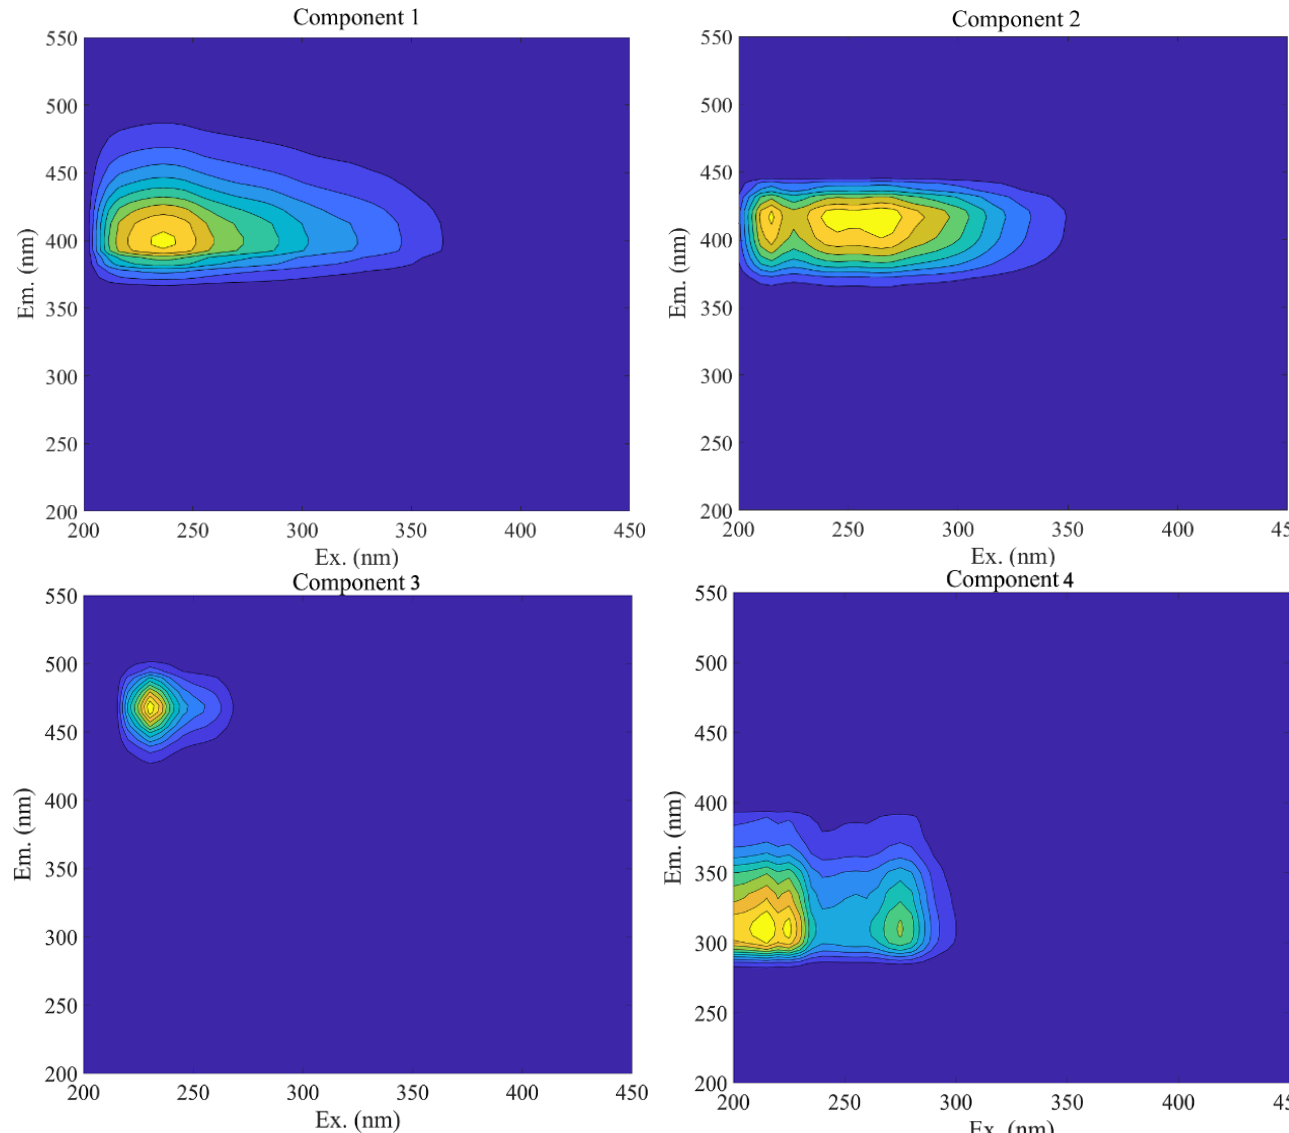
Figure 2. EEM contours for the four major fluorescent components identified by PARAFAC analy- sis.